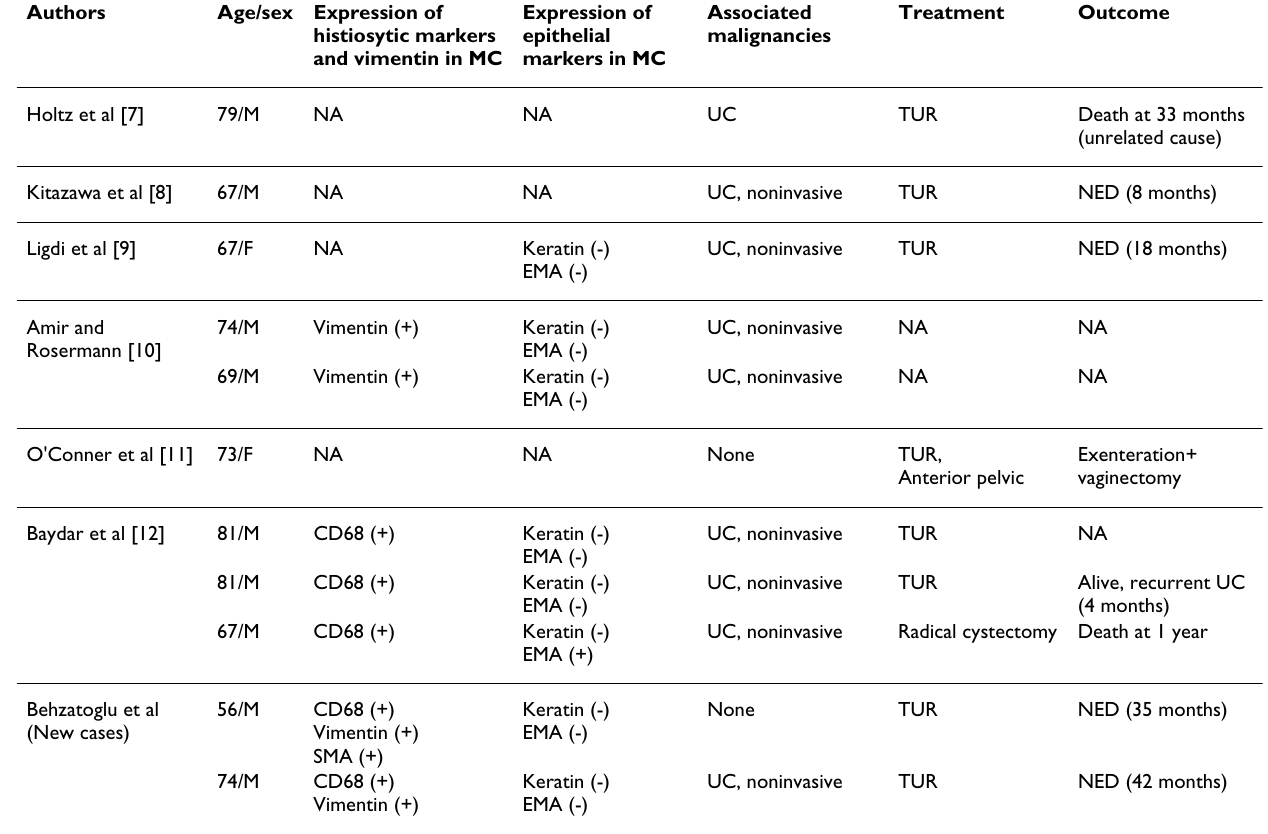
Table 2: Literature Review of Giant Cell Tumor of Urinary Bladder Authors